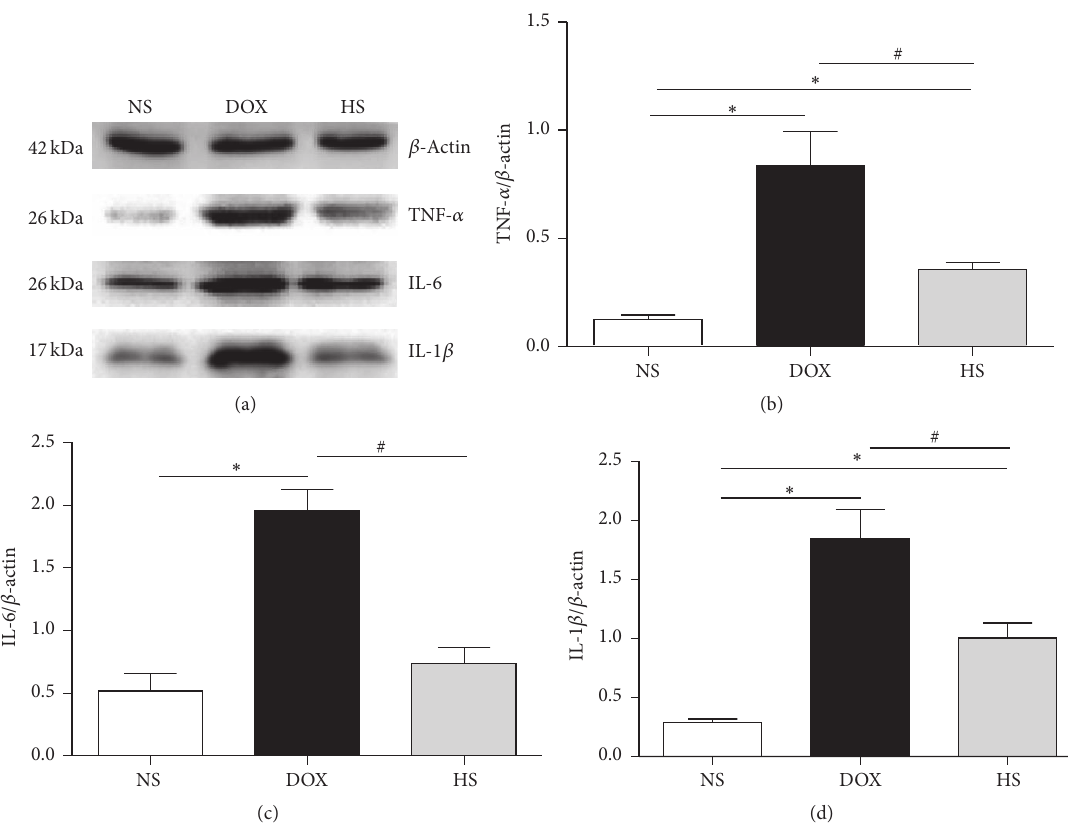
Figure 5: The anti-inflammatory effect of hydrogen-rich saline on hepatic tissue. Representative expression of inflammatory-related proteins in the liver after the treatment was detected (a–d). Data are shown as mean ± SD, 𝑛 ≥ 3 . ∗ 𝑃 < 0.05 versus NS group; # 𝑃 < 0.05 versus DOX